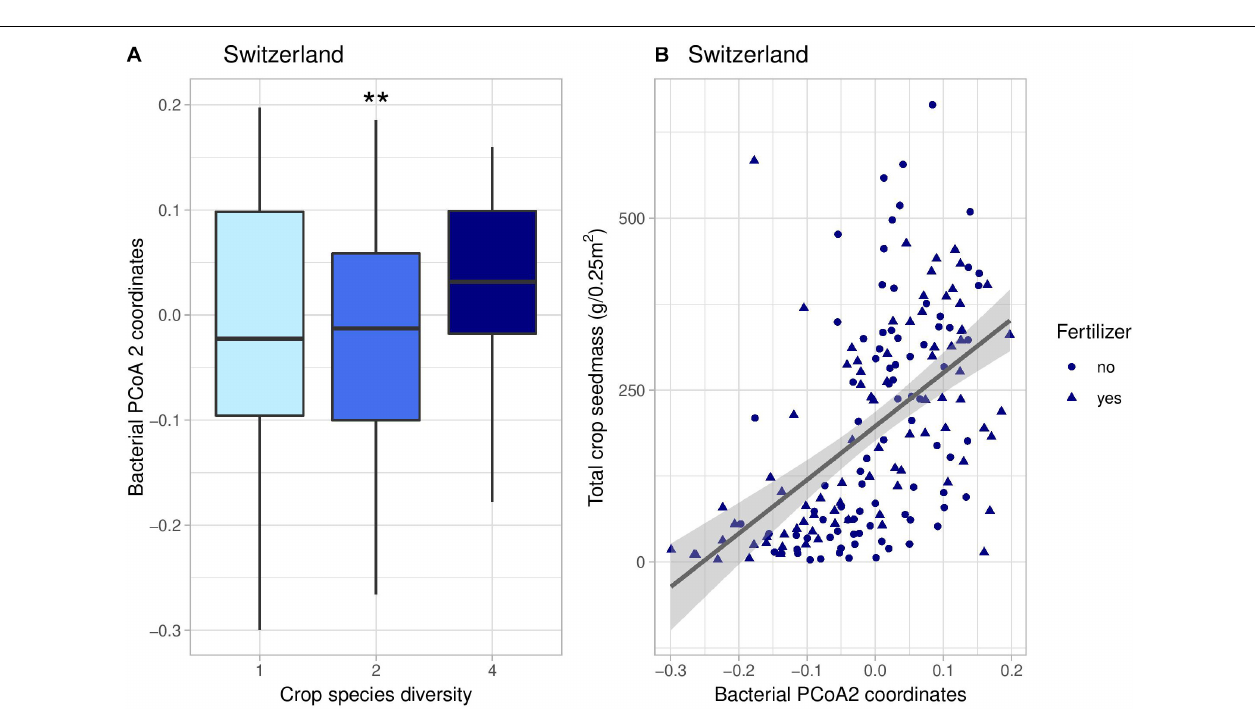
FIGURE 4 | Effects of crop species number on the coordinates of the second axis of fungal PCoA decomposition (A) and correlation between these coordinates and total crop yield (B) in Switzerland. In panel (B) , the line represents the linear regression (coefficient: − 288, p -value = 0.00037). *** indicates the significance level of the effects of crop species number on fungal PCoA 2 ( p -value < 0.001).